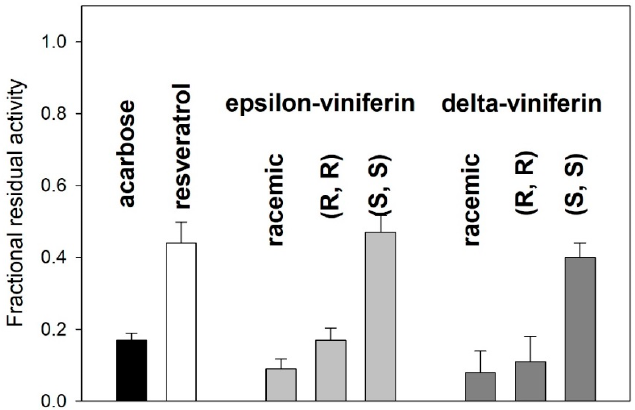
Figure 5. Residual enzyme activity in the presence of viniferin isomers, of their purified enantiomeric forms, and of their racemic forms. Final concentration of each inhibitor species (including acarbose and resveratrol) was 1 mM.